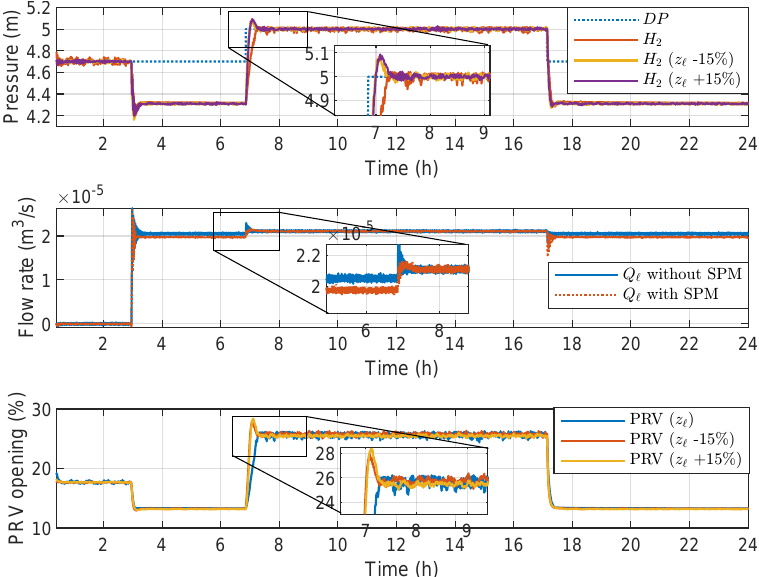
Figure 8. Case 2: Pressure control and management in a pipeline with a leak after the controlled node. Including ± 15% of uncertainty in the leak location.